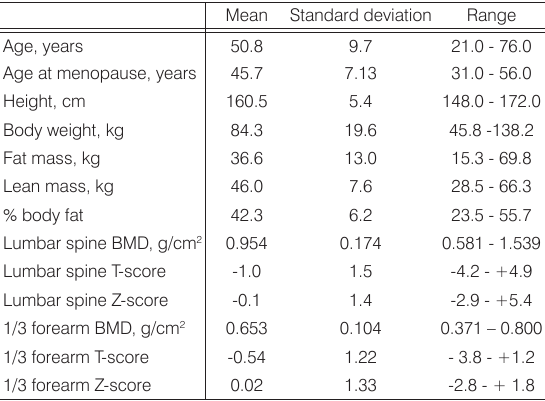
Table 1. Anthropometric and BMD values at the lumbar spine and 1/3 proximal forearm (in g/cm 2